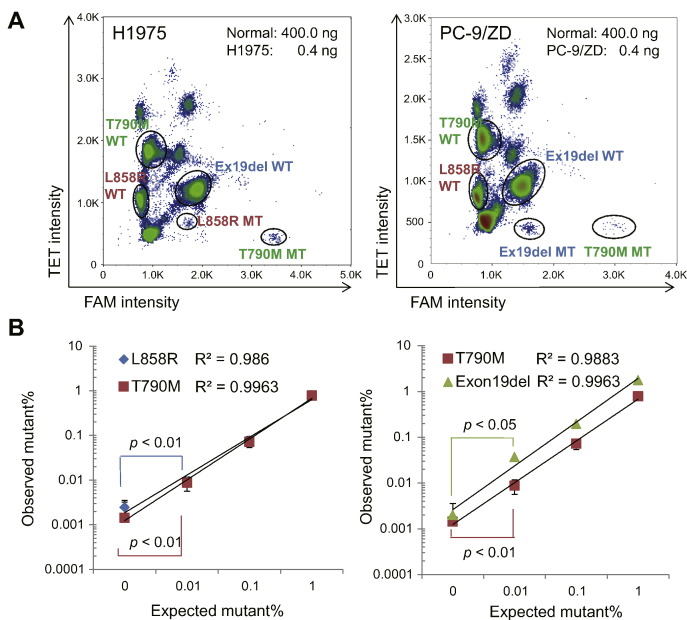
Serial dilutions of positive controls were analyzed for each EGFR mutation under study. Testing 0.04 and 4 ng of genomic DNA from H1975 cells harboring EGFR mutations L858R and T790M (A) or PC-9/ZD cells harboring EGFR exon 19 deletion and substitution T790M (B); n = 5.